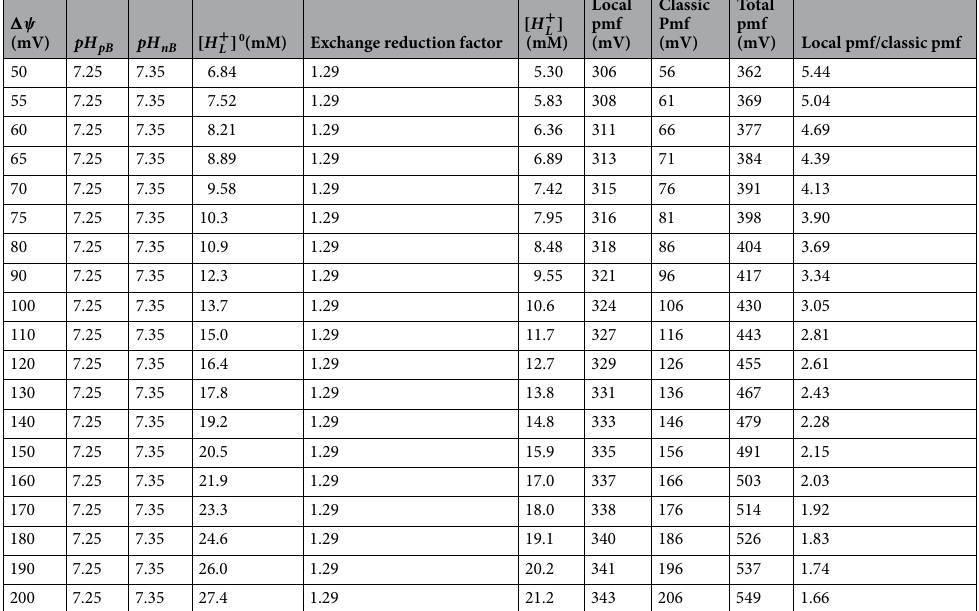
Table 2. Mitochondrial protonic motive force (pmf) and the associated properties including local pmf, calculated as a function of membrane potential �ψ using Eqs. (2−4) based on the measured properties ( pH pB , , �ψ) with the known reaction medium compositions of ref. 61 . The cation concentrations, proton- pH nB cation exchange equilibrium constants and cation exchange reduction factor (1.29) are from Table 1; and the temperature T = 310 K. The “local” pmf is the last term in Eq. (2), while the first two terms of Eq. (2) give the “classic” Mitchellian pmf. Adapted and updated from Ref. 5 .